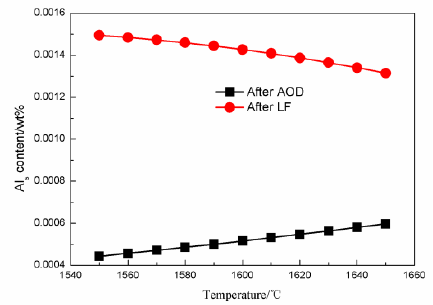
Figure 9. Effect of the slag on the content of Al s in steel.